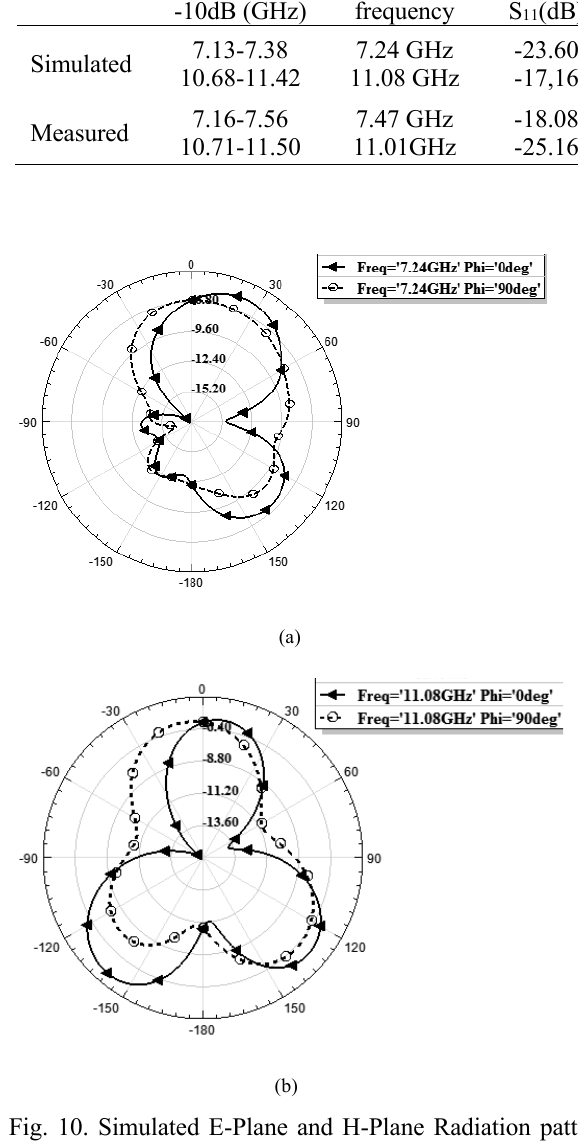
Fig. 10. Simulated E-Plane and H-Plane Radiation patterns of the proposed antenna at different frequencies (a) 7.24GHz and (b) 11.08GHz